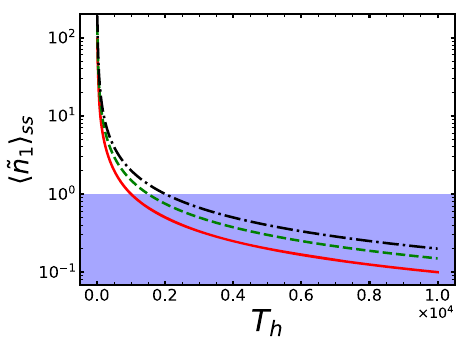
Fig. 3 Numerical vs. approximate mean phonon number. The steady-state Fig. 4 Single mechanical resonator cooling. The steady-state mean phonon mean phonon number h ~ n 1 i as a function of the hot bath temperature T h . ss number h ~ n 1 i as a function of the hot bath temperature T h . Solid, dashed, and The solid line is for Eq. (11) in case of ignoring ζ 2 terms from h ~ n a i (Eq. (9)), ss 1 ss dot-dashed lines are for T 1 = 1×10 − 4 , 2×10 − 4 , and 3×10 − 4 , respectively. The and the dot-dashed line represents h ~ n 1 i calculated by the numerical ss other parameters are ω a = 1, ω 1 = 1×10 − 7 , κ h = κ c = 1×10 − 8 , κ 1 = 1×10 − 12 , simulation of the master equation given in Eq. (8). In the numerical T c = 1×10 − 5 , and g 1 = 1×10 − 9 . All the parameters are scaled with the optical simulation, we use truncated Hilbert space with 7 photon states and 70 frequency ω a = 2 π ×10 14 Hz. The temperatures in SI units are given as T c ≈ 5 phonon states. The use of small Hilbert space dimensions for the optical (cid:6) 1 for all parameters considered. We mK, T 1 ≈ 0.5, 1, and 1.5K for solid dashed, dot-dashed lines, respectively. The mode is justi fi ed, because h ~ n a i ss hot bath temperature is higher by many orders of magnitude and it is have veri fi ed that the increase in the Hilbert space dimensions does not approximately 4×10 4 ≲ T h ≲ 4×10 7 affect the results. Parameters: (cid:2) n 1 ¼ 10, (cid:2) n c ¼ 0 : 5, ω a = 1, ω 1 = 1 × 10 − 7 , κ h = κ = 1 × 10 − 8 , κ = 1 × 10 − 12 , and g = 1 × 10 − 9 . All the parameters are scaled c 1 1 with the optical frequency ω a = 2 π × 10 14 Hz.